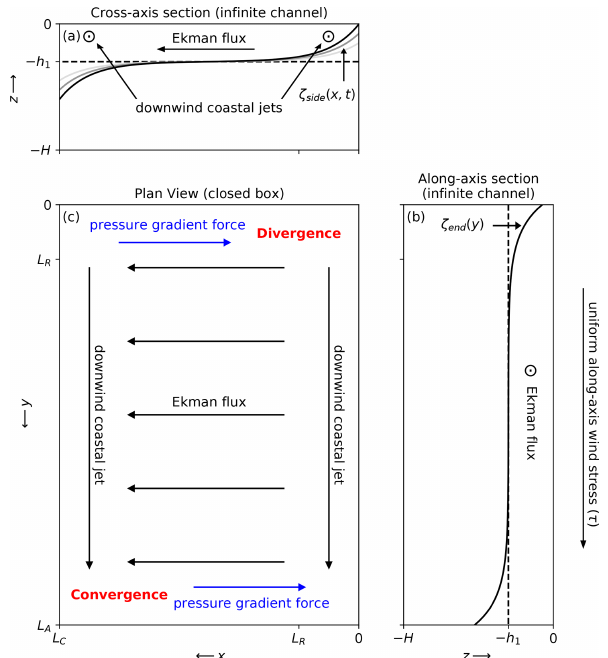
Figure 10. Diagram of the two-layer, infinite channel, interface displacement solutions in the (a) cross-axis and (b) along-axis di- rections, as forced by a uniform along-axis wind stress. The plan view (c) shows the surface divergence and convergence that are rea- soned to occur when considering the infinite channel solutions in a closed